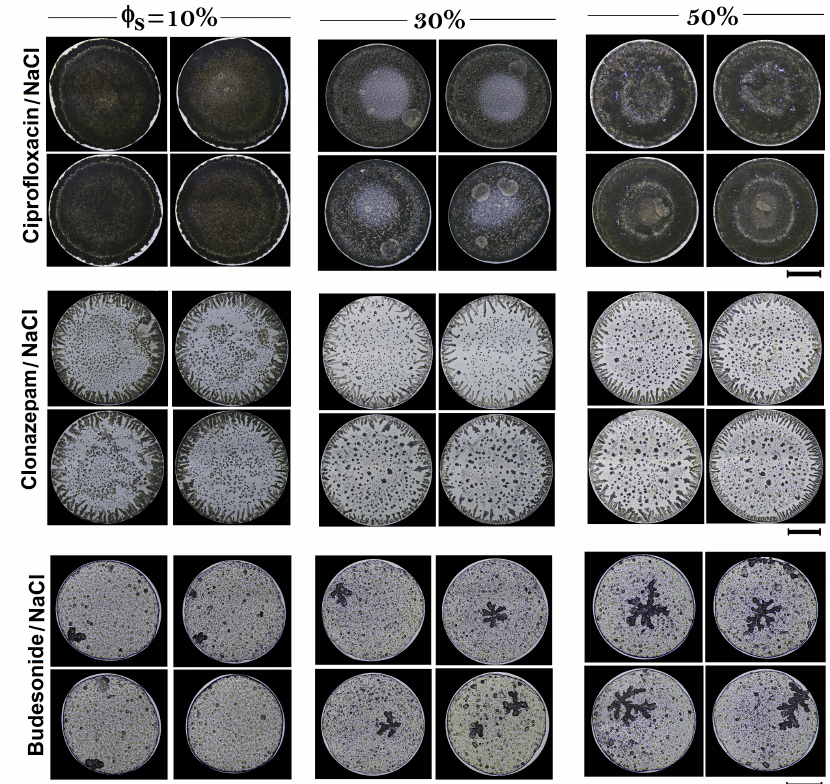
Figure 6. Reproducibility of patterns in dried droplets of Criprofloxacin/NaCl, Clonazepam/NaCl, and Budesonide/NaCl produced by different dilutions of tap water. Patterns formation was carried out at T s = 63 ◦ C, and RH = 25%. The length of the black lines indicate 1 mm.